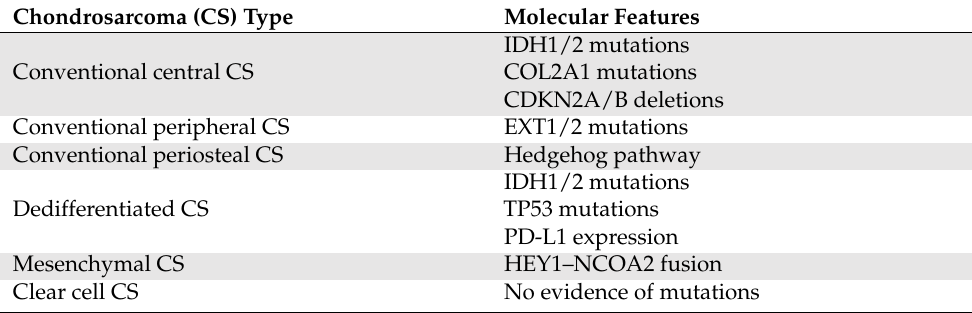
Table 2. Chondrosarcoma types and respective molecular